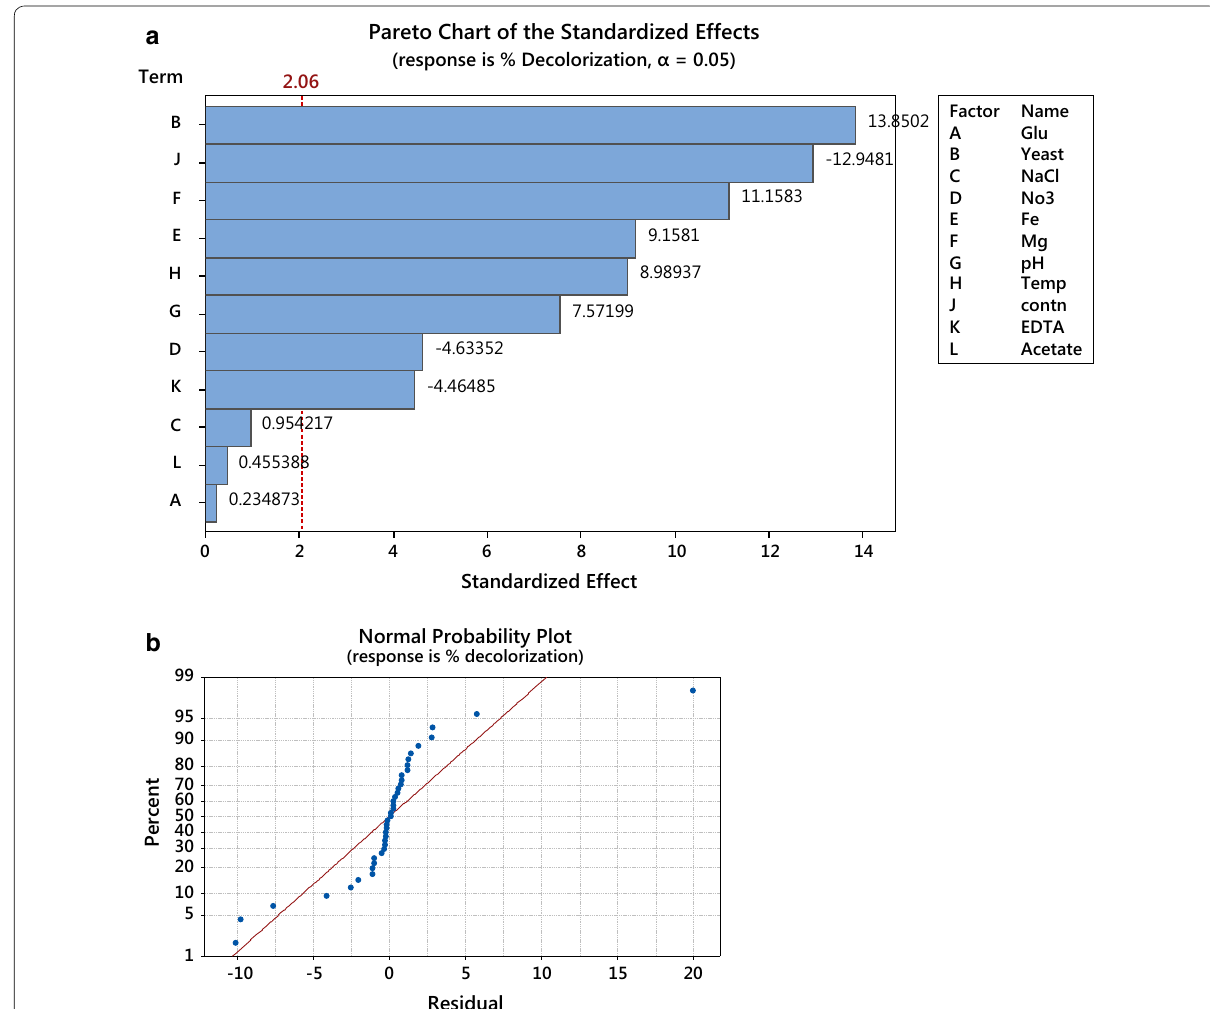
Fig. 5 a Pareto charts ranking the standardized effects of the tested factors. The vertical line in chart represent a reference line, any factor that extends past this line is of significant effect at α 0.05 (significance level). E-value (the standardized effect of each factor) was calculated using = Minitab software (version 17). The magnitude of the E-value of the tested factor indicated its significance in affecting the response, while the posi- tive or negative sign of the E-value was an indication of its positive or negative influence on the responses, respectively. b Normal probability plot of residuals for isolate B1. The straight line in the graph represents the mathematical regression equation (which determines the expected data), while the dots in the plots represent the actual observed data. As shown in figure the dots generally formed a line consistent with regression line, therefore the residuals (the difference between observed data and expected data) are considered normally